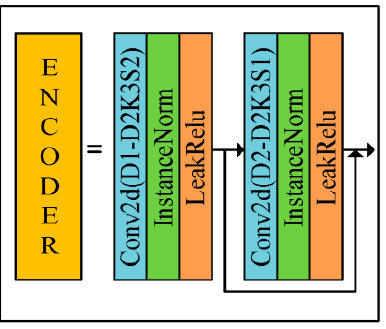
Figure 7. Encoder module.